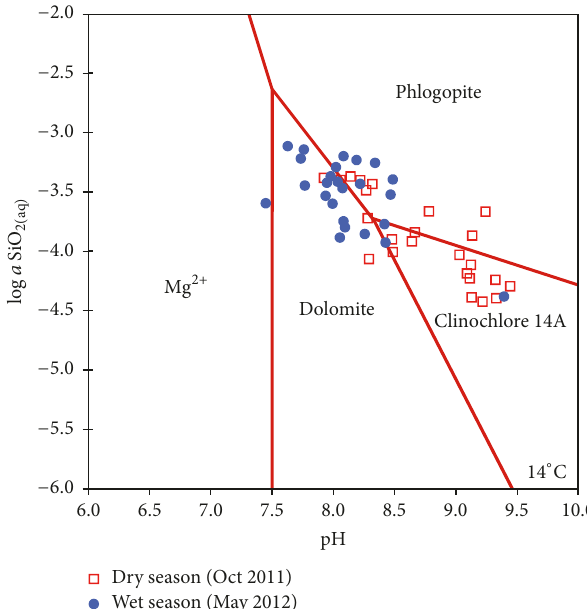
Figure10:MineralstabilitydiagramfortheMgO–Al 2 O 3 –SiO 2 –H 2 O system. The aqueous silica (log 𝑎 SiO 2( aq ) ) concentrations versus pH values for the dry season and wet season groundwater samples are plotted on the diagram using The Geochemist’s Workbench (cid:2) software [101]. Solid lines represent saturation at 14 ∘ C and 1-bar pressure for the selected mineral